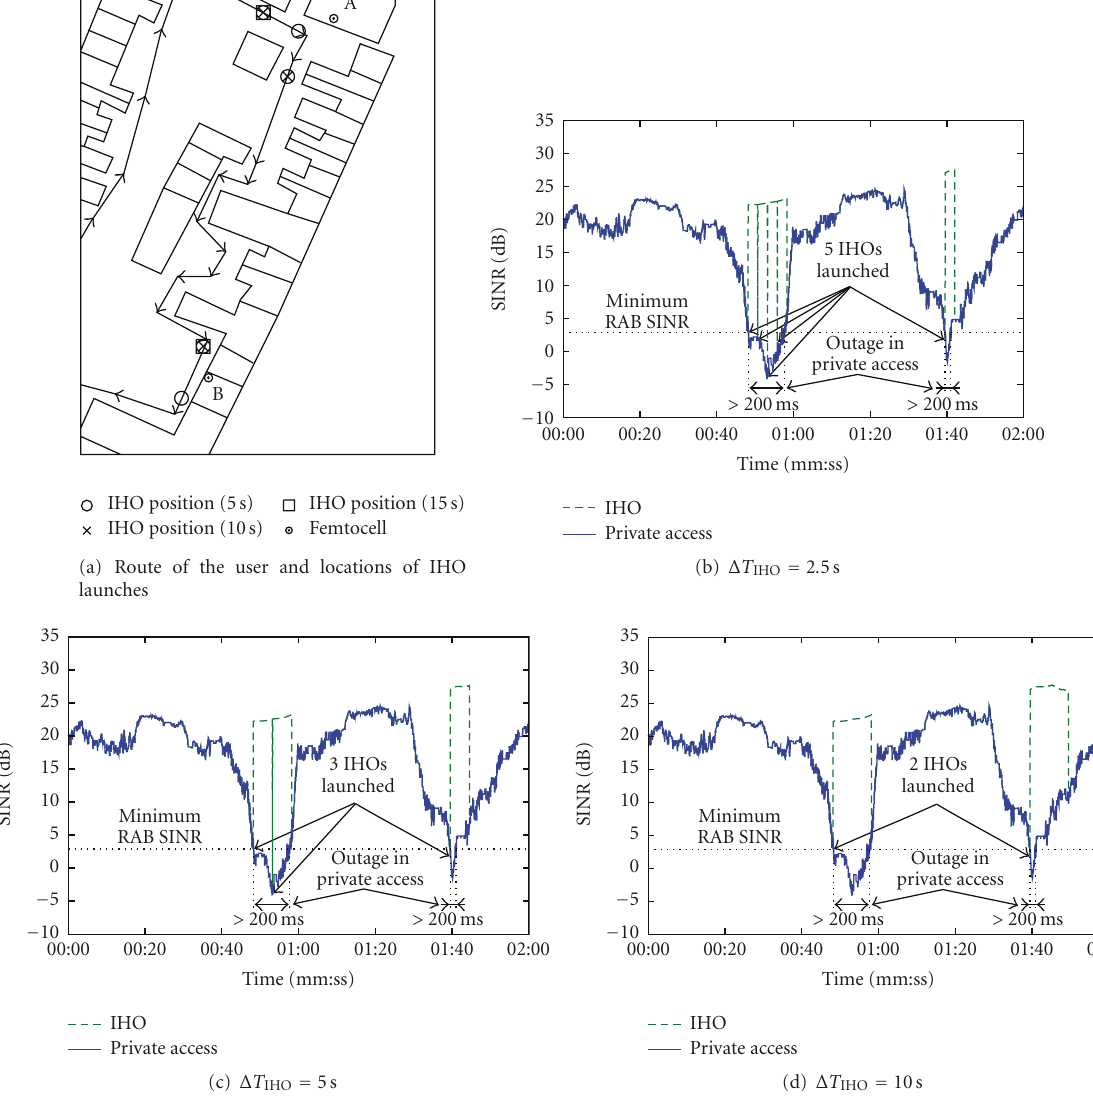
Figure 4: Performance comparison of CSG and IHO for a mobile nonsubscriber ( Δ Q IHO =